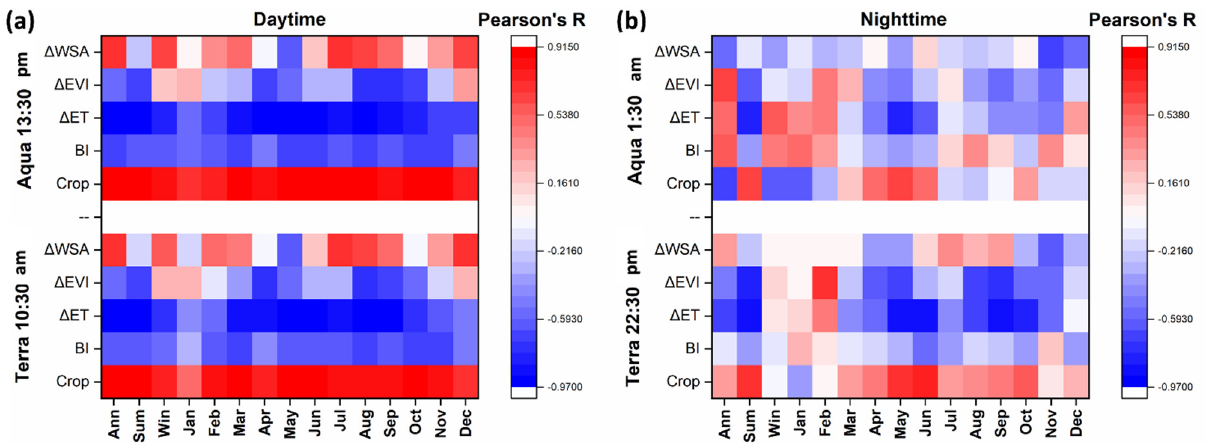
Figure 9. Pearson’s correlation coefficient plot of SUHII with the different driving parameters during the ( a ) daytime (Terra 10:30 am and Aqua 13:30 pm) and ( b ) nighttime (Terra 22:30 pm and Aqua 01:30 am).